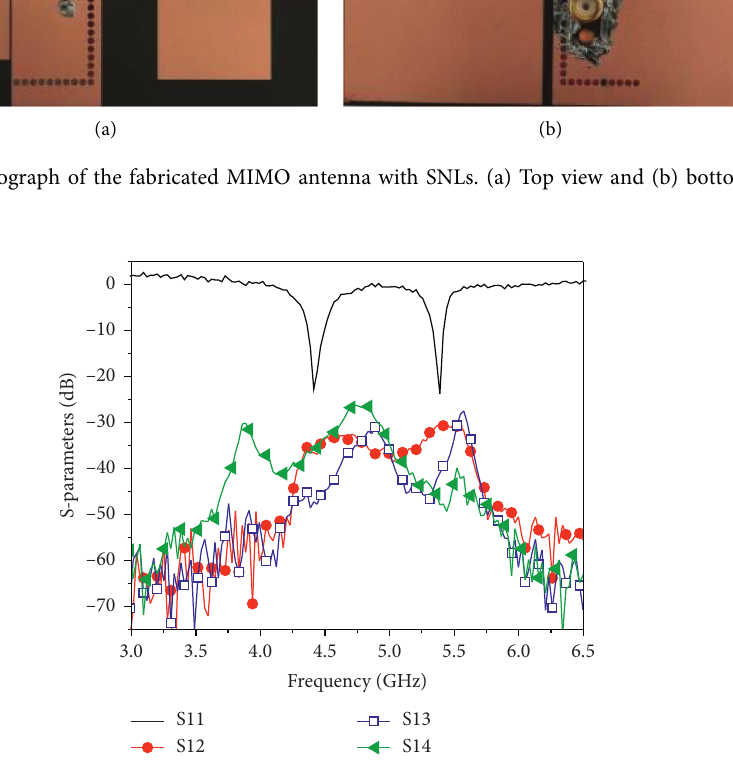
Figure 12: Measured S-parameters of the MIMO antenna with